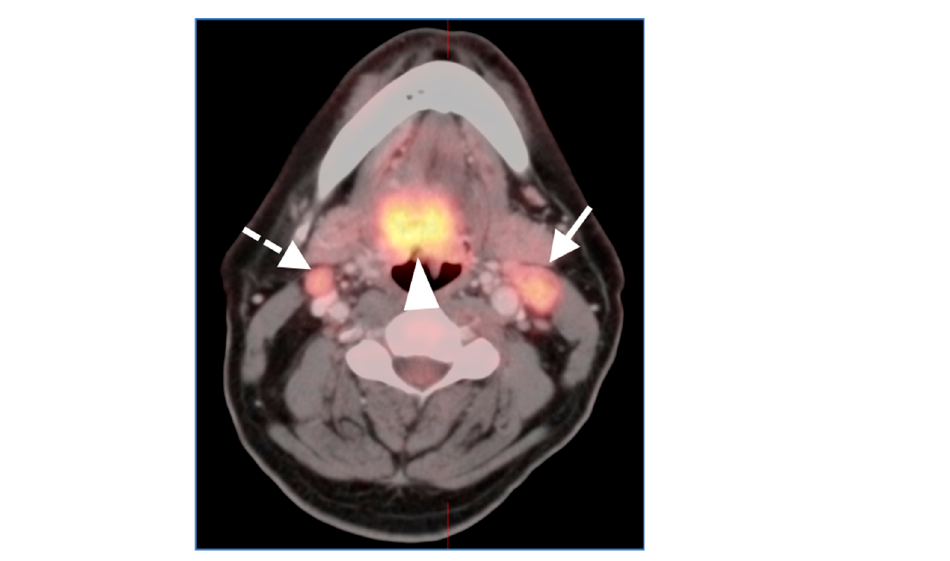
Figure 2. Squamous cell carcinoma of the central base of tongue with extension into the oral tongue (solid white arrowhead) with bilateral hypermetabolic lymph nodes. The left level 2A node (solid white arrow) is clearly large and heterogeneously enhancing, consistent with tumor involvement. The right sided node (dashed arrow) is smaller but similarly hypermetabolic, and was benign at biopsy. There is considerable overlap in metabolic activity between benign/reactive and malignant nodes.